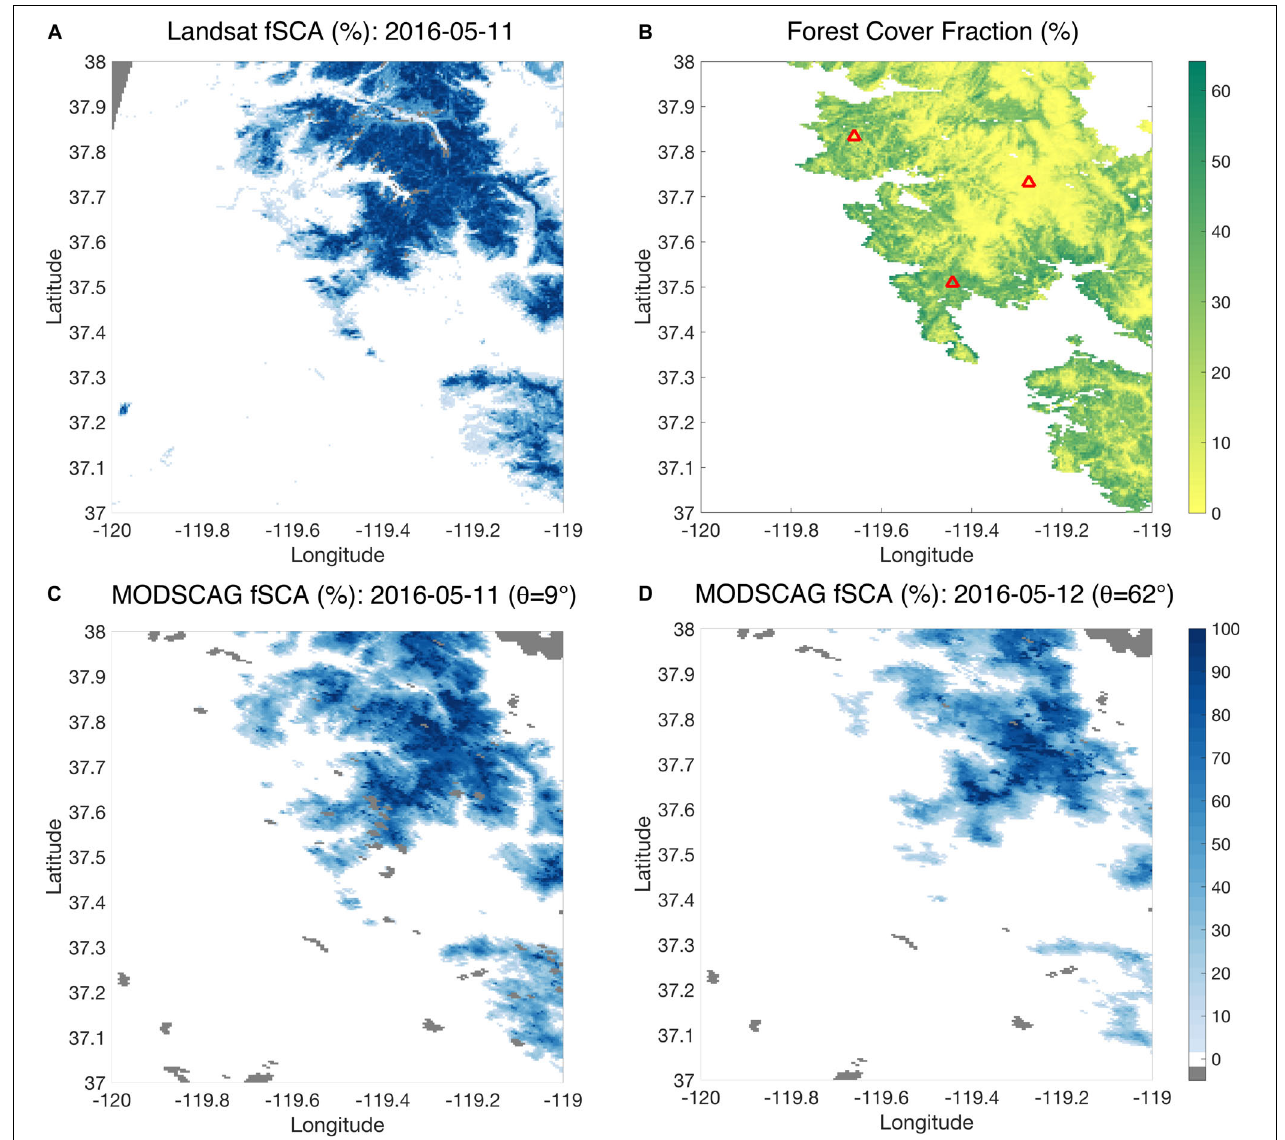
FIGURE 3 | (A) An example of a Landsat fSCA map for a tile covering the Tuolumne River watershed examined herein. (B) Map of forest cover over the tile including three sample points (red triangles) used for illustration in Figure 6 . (C) Coincident (within 1 day of Landsat image) MODSCAG fSCA maps at (C) low viewing angle and (D) high viewing angle, illustrating the differences (errors) caused by viewing geometry effects. Specifically, the effect of “pixel elongation” described in the text is apparent in (D) . Gray areas in fSCA maps represent